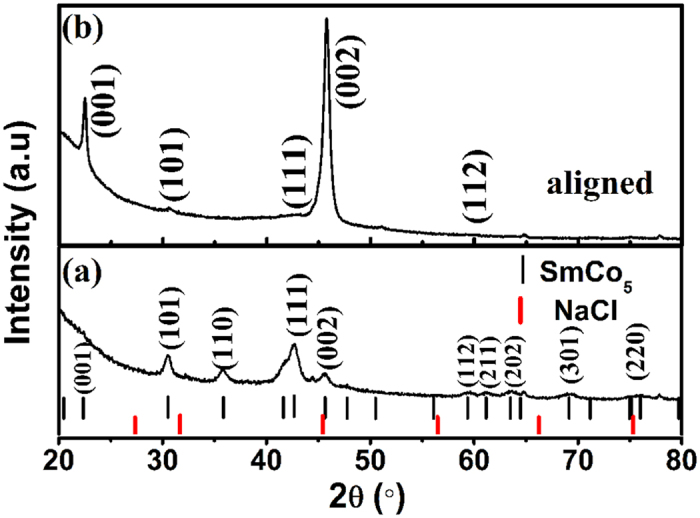
The XRD patterns of (a) randomly oriented SmCo5 nanoflakes, (b) aligned SmCo5 nanoflakes resin composite.